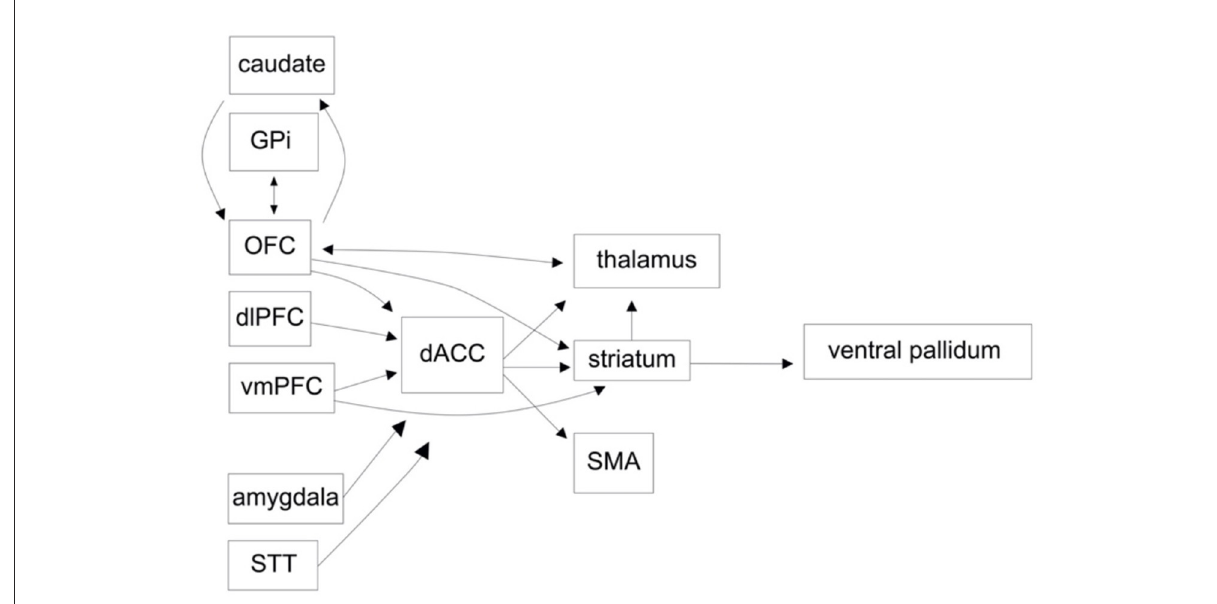
FIGURE1 A functional circuit diagram depicting relevant afferent and efferent connectivity in the cortico-striatal-cortical and orbitofrontal circuits, implicated in the pathogenesis of obsessive compulsive disorder